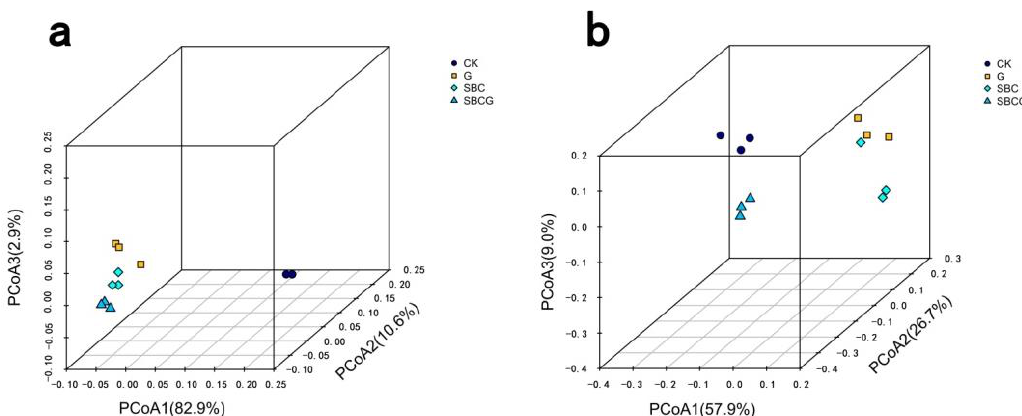
Figure 5. Principal coordinate analysis of bacterial ( a ) and fungal ( b ) genera in IAC mining wasteland soil in the un-amended control (CK), alfalfa revegetation (G), sludge biochar amendment (SBC), and combined amendment (SBCG) treatments.